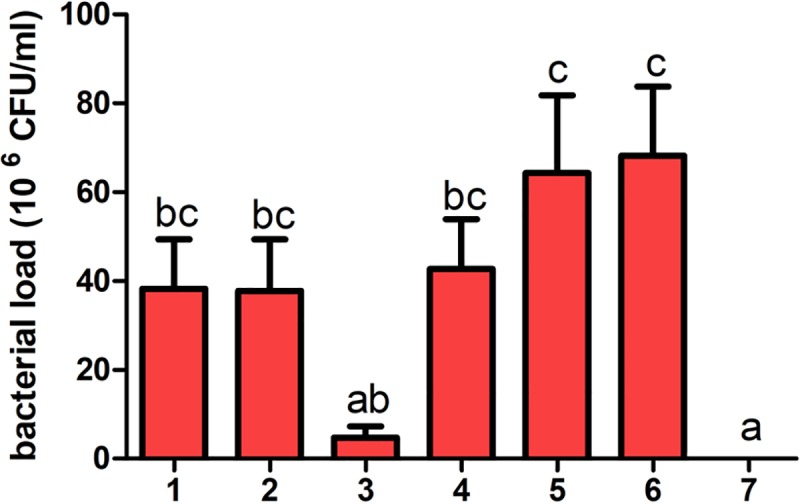
Bacterial load of dead chicks and euthanized chicks’ liver during the experiment.During the experiment, Significant difference of liver bacterial load between group3 and other groups is observed. The groups with different letters are significantly different (P < 0.05).